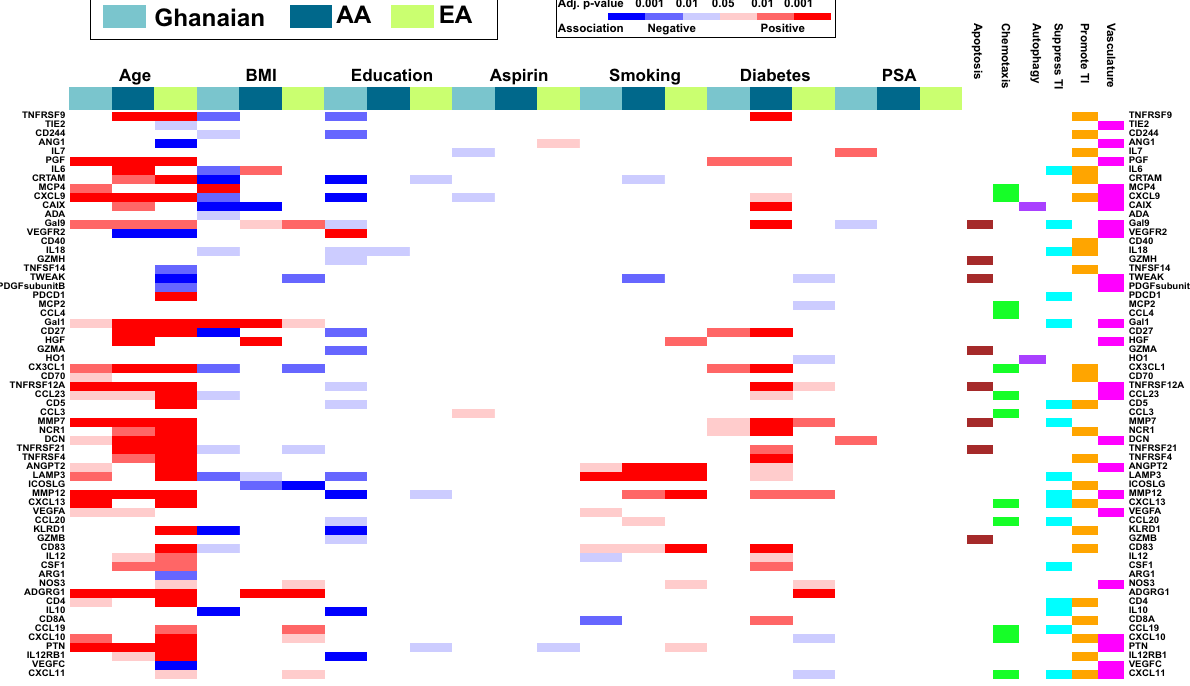
Fig. 2 Association of socio-demographic and clinical characteristics with systemic immune-oncological proteins in Ghanaian ( n = 654), AA ( n = 374), and EA ( n = 454) men without prostate cancer. The association of the 82 immuno-oncological proteins (as continuous variables) with age, BMI, education, aspirin use, smoking, diabetes, and PSA was assessed in men without prostate cancer using a multivariable linear regression test. P values were adjusted for multiple comparison. An analyte was considered signi fi cantly associated with clinical and socio-demographic covariables if the multivariable model yielded a false discovery rate (FDR)-adjusted P < 0.05 on the F-statistic. Analytes that did not have a signi fi cant association with any of the clinical/ sociodemographic variables in at least one of the population groups are not presented in the heatmap. Blue represents a negative association while red represents a positive association. The signi fi cance level (FDR-adjusted two-sided P value-based) for each association is color-coded. Source data are provided as a Source Data fi le. TI tumor immunity, AA African American, and EA European